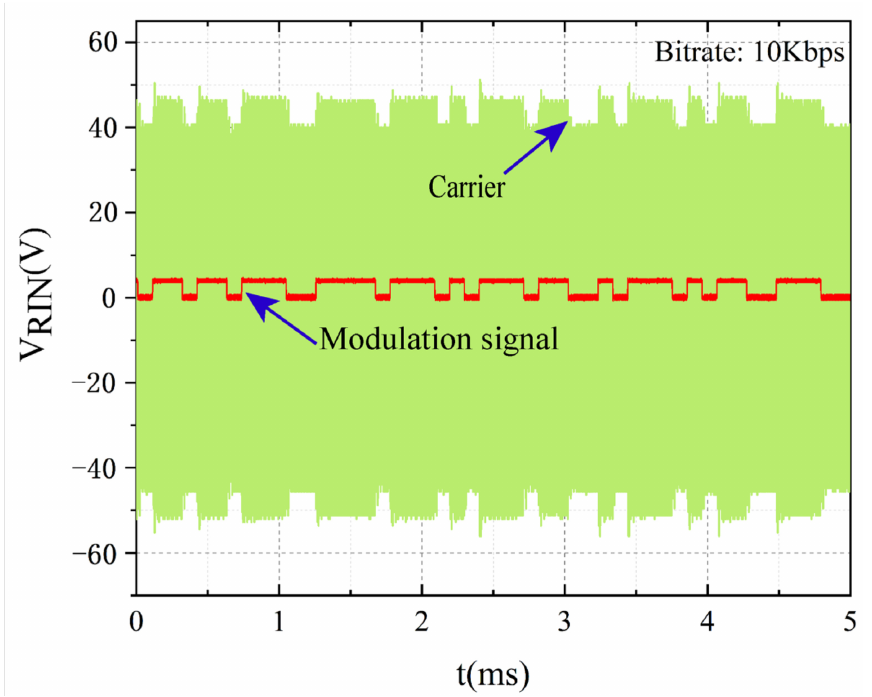
Figure 9. Carrier envelope at impedance modulation rate of 10